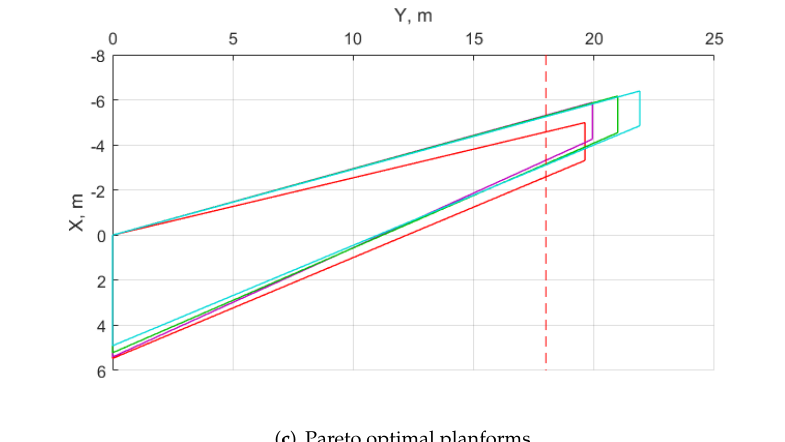
Figure A1. Optimization results for the forward-swept NLF aircraft.